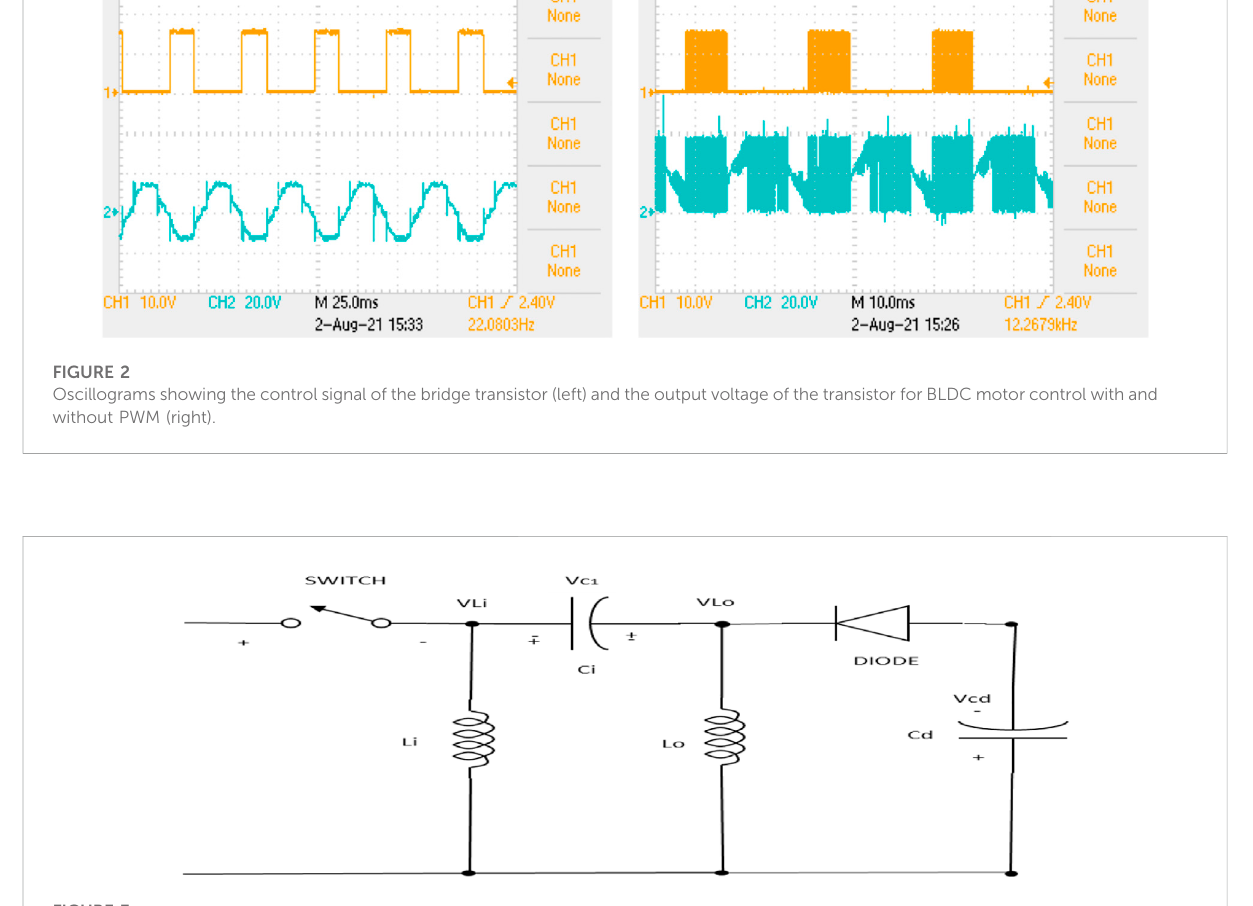
FIGURE 3 Basic circuit of modi fi ed Zeta converter.